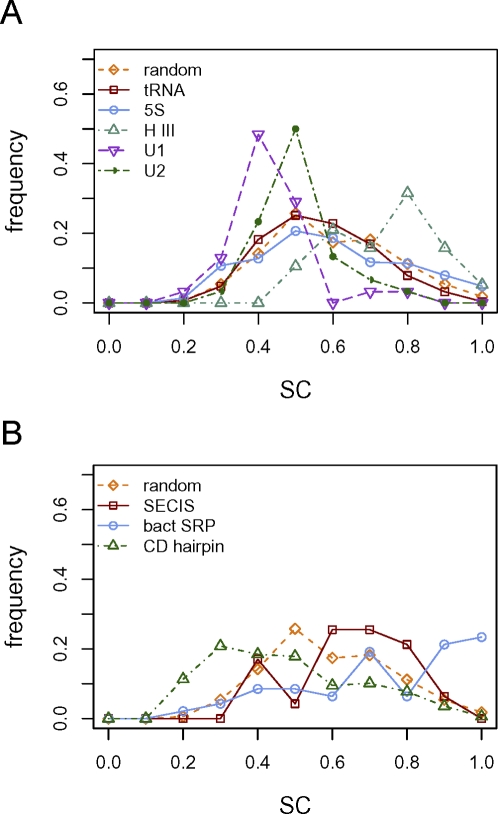
SC values for RNA classes.Histograms of self-containment index values for (A) tRNAs, 5S rRNAs (5S), Hammerhead type III ribozymes (H III), U1 spliceosomal RNAs, and U2 spliceosomal RNAs, as compared to random structures; and (B) SECIS elements, bacterial SRP RNAs (bact SRP), and hairpins derived from protein-coding regions of mRNAs (CD hairpin), as compared to random structures.